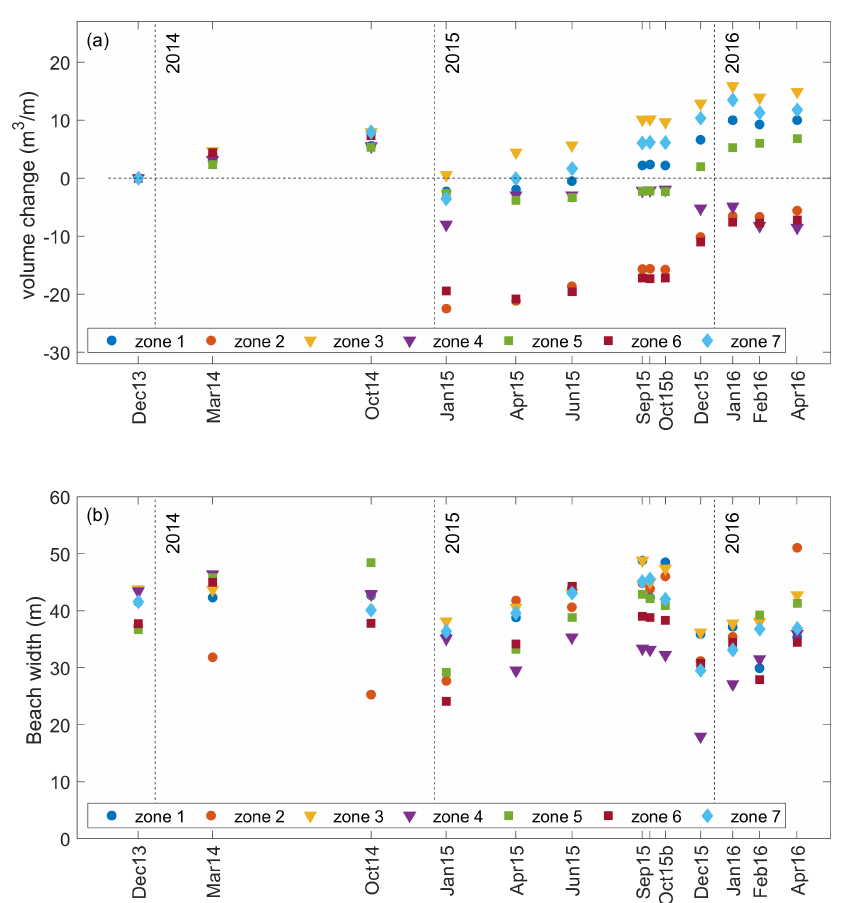
Figure 9. ( a ) Dune volume change throughout the measurement period with respect to the initial dune volume. Colored dots show dune volume for the zones defined in Section 4.3; ( b ) the beach width for each zone (between 1 m and 3 m contour lines) throughout the measurement